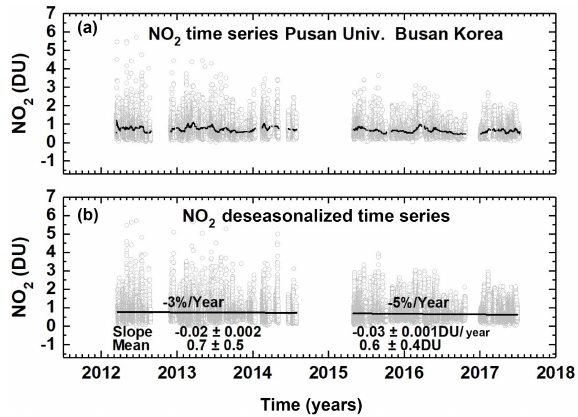
Figure 8. (a) Pusan University in Busan C ( NO 2 ) daily time series (grey) and (b) deseasonalized time series with linear